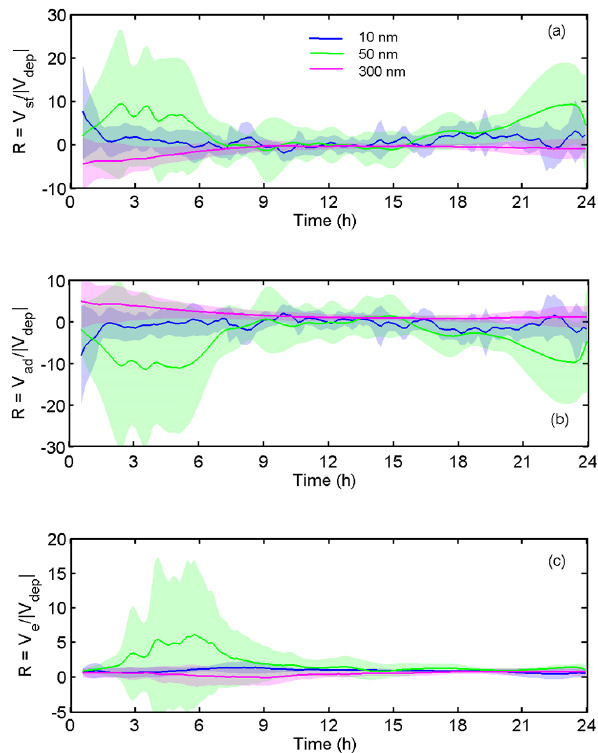
Figure 9. Diurnal variation of change velocity for (a) storage, (b) aerosol dynamics and (c) vertical exchange for selected particle sizes. The lines present the ratios of the average change velocities (cid:104) V (cid:105) to the average deposition term according to (cid:10)(cid:12) (cid:12) (cid:12)(cid:11) obtained from (cid:12) V dep model simulations for each 10min period and the shaded areas the variation range as ± σ V (cid:10)(cid:12) (cid:12) (cid:12)(cid:11) around the averages. (cid:12) V dep